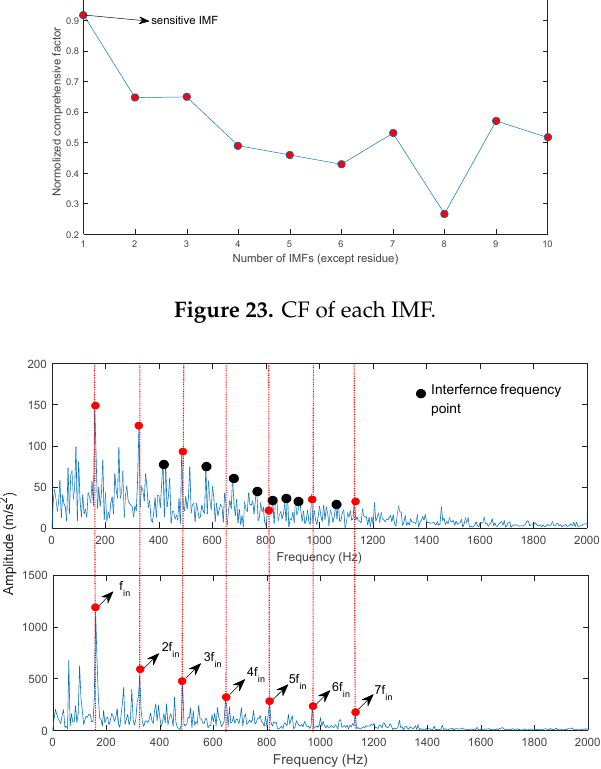
Figure 24. Comparison of extraction fault frequency for ECEEMDAN and CEEMDAN.